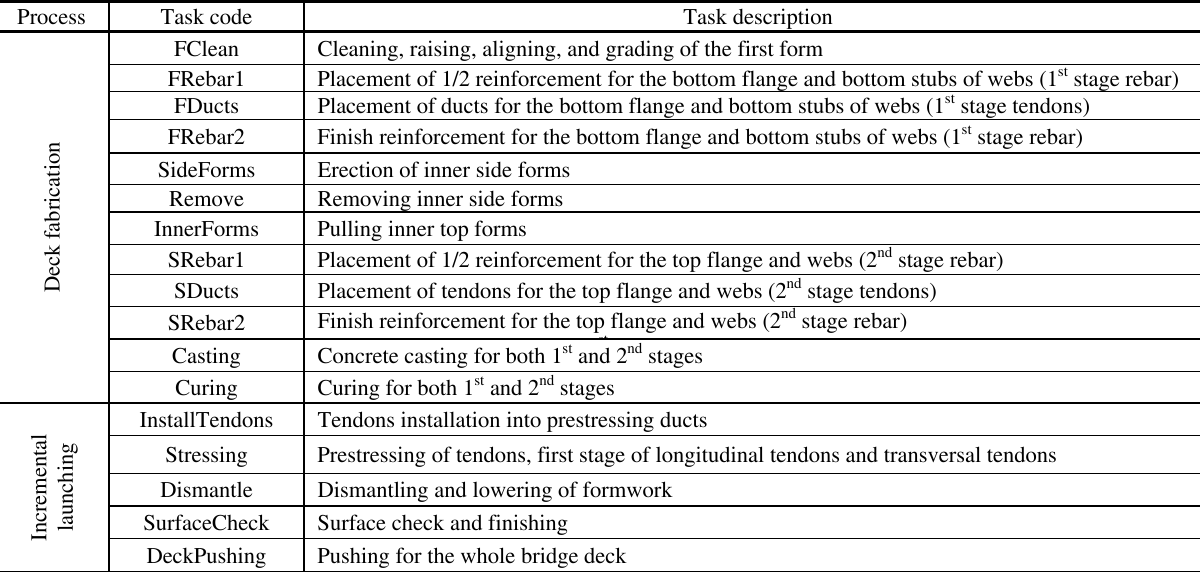
Table 3 . Processes and tasks of multiple forms method